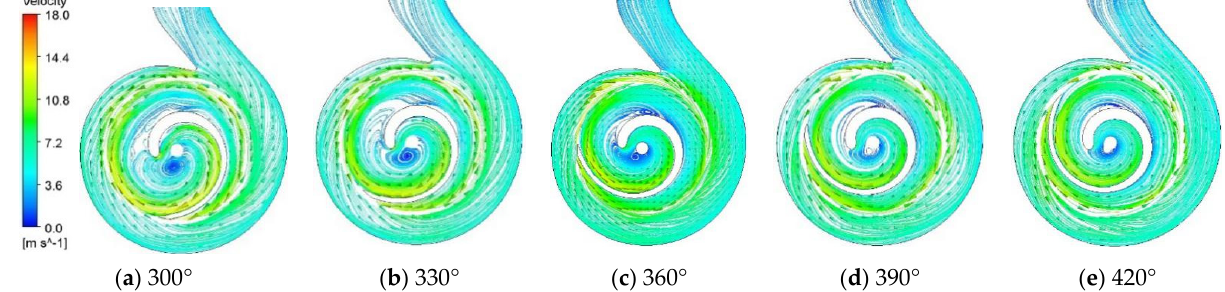
Figure 15. Velocity vector of the pump under the designed flow rate condition.